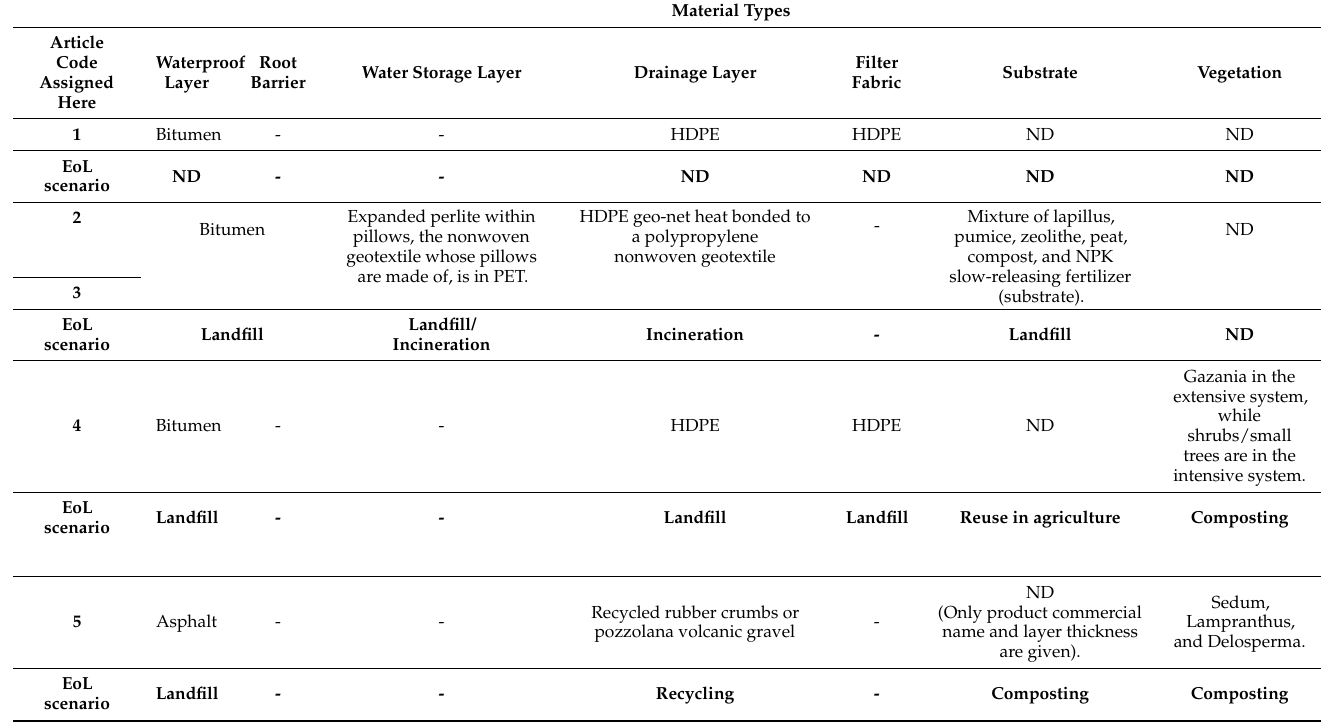
Table 5. Waste treatments assigned to each layer of the considered green roofs in the eleven analyzed LCA and LCC studies (ND = not declared in the article; - = not present in the considered green roof